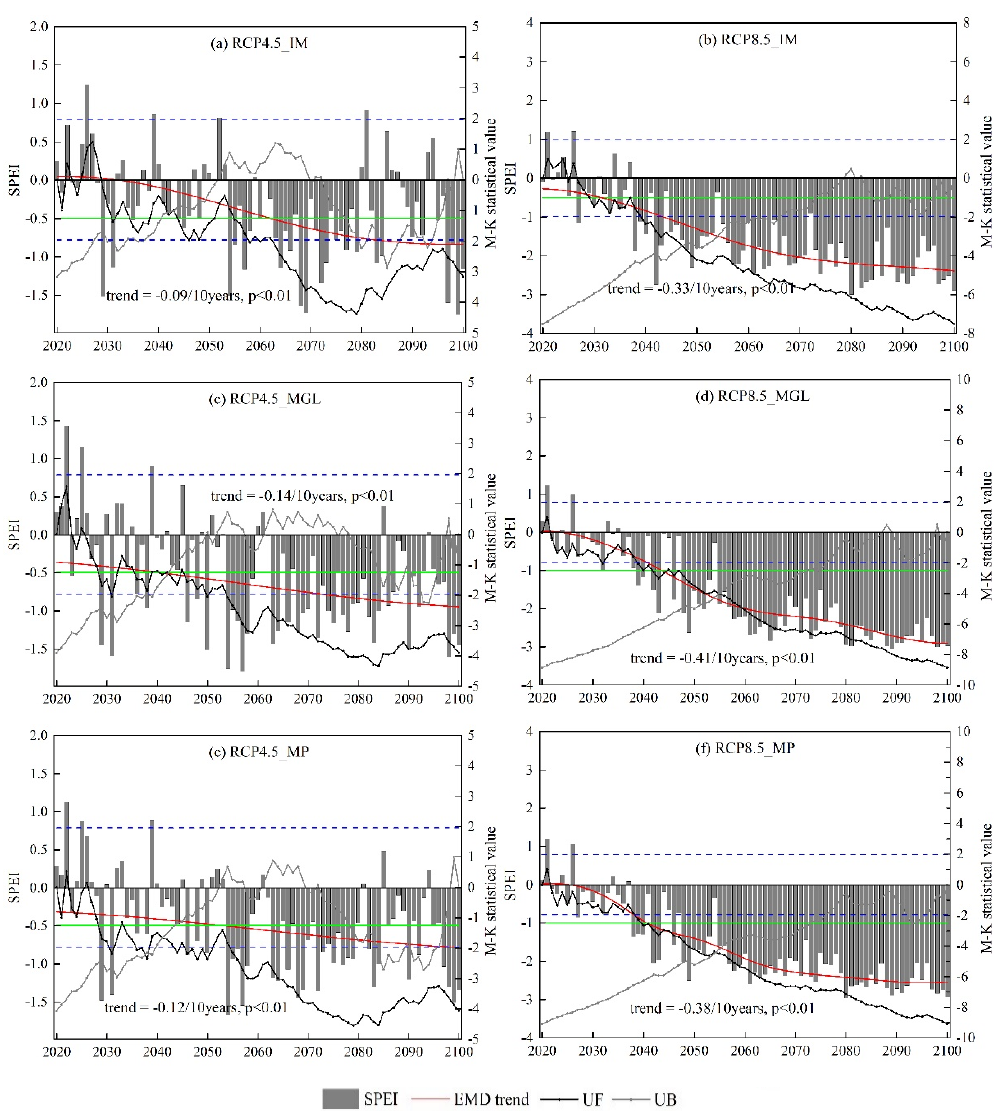
Figure 6. Changes in the standardized precipitation evapotranspiration index (SPEI) during 2020–2100 in Inner Mongolia ( a , b ), Mongolia ( c , d ) and the Mongolian Plateau ( e , f ) under the RCP4.5 and RCP8.5. The bars represent the annual series of the SPEI, with drought occurring when bars cross the threshold represented by the lower green line at SPEI = − 0.5. The red lines represent the trends in empirical mode decomposition. UF and UB curves are the progressive and retrograde series obtained by the Mann–Kendall statistical test; the point at which the UF and UB lines cross indicates the start of abrupt change; the blue dotted line represents the confidence line ( p = 0.05).